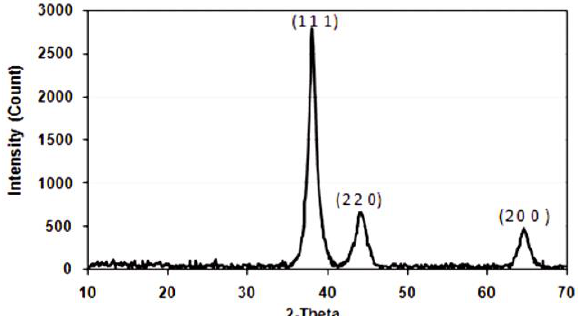
Figure 22. Face-centered-cubic (fcc) crystal lattice of silica cored gold nanoshells determined from their XRD spectrum [151].